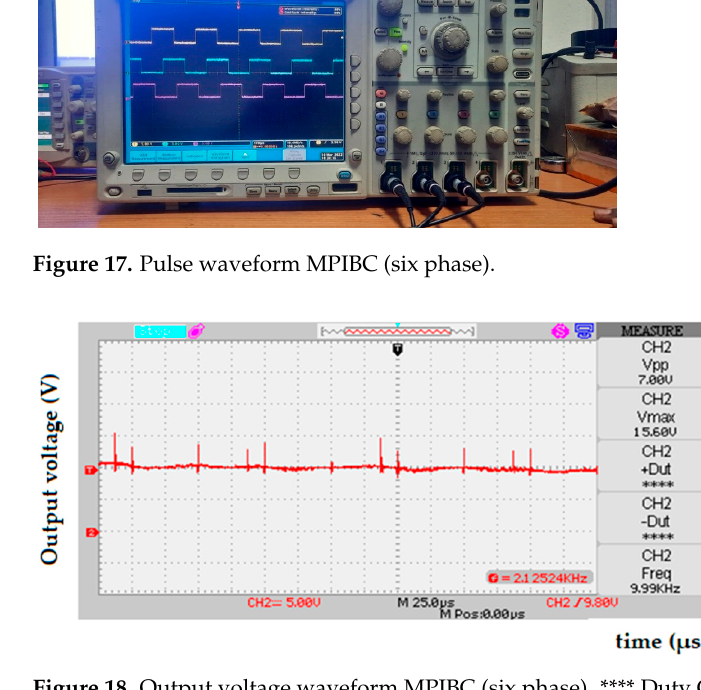
Table 15. Output voltage, current and power at f s = 5 kHz.